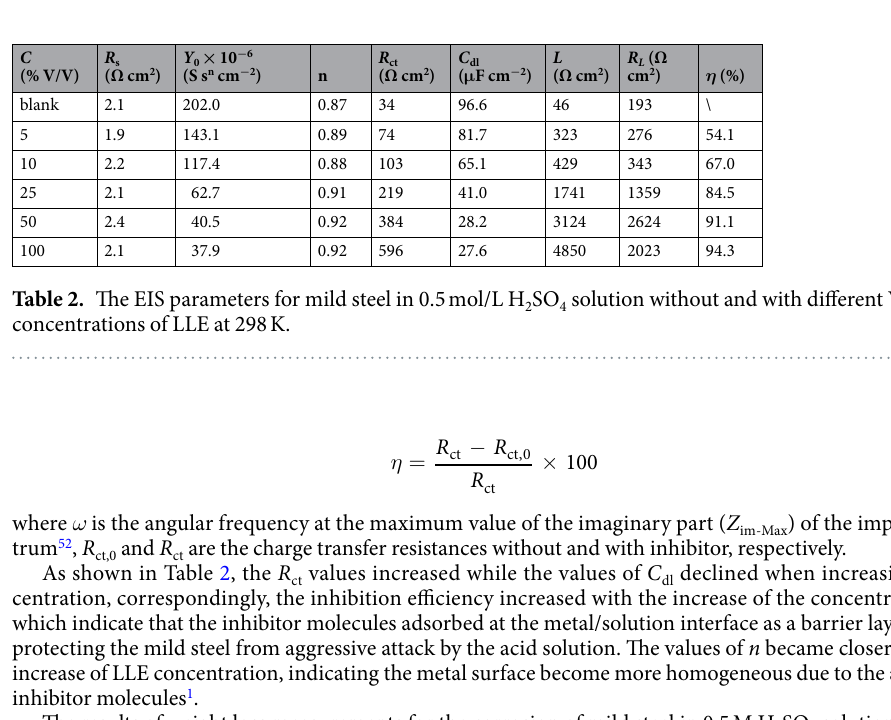
Figure 4. Equivalent circuits used to fit the EIS.